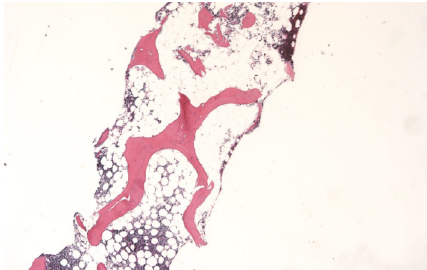
Figure 5: The bone is normocellular with megakaryocytic hyper- plasia and moderate fibrosis (bone marrow, left posterior iliac crest, clot section, and trephine core biopsies, 100x).